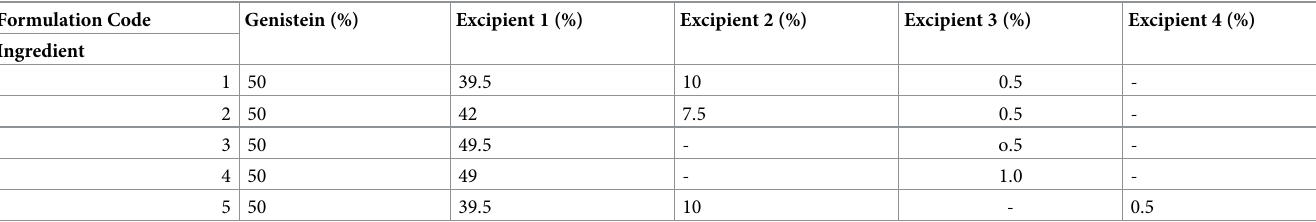
Table 1. Presentation of the different formulation recipes that were examined during this study. Formulation